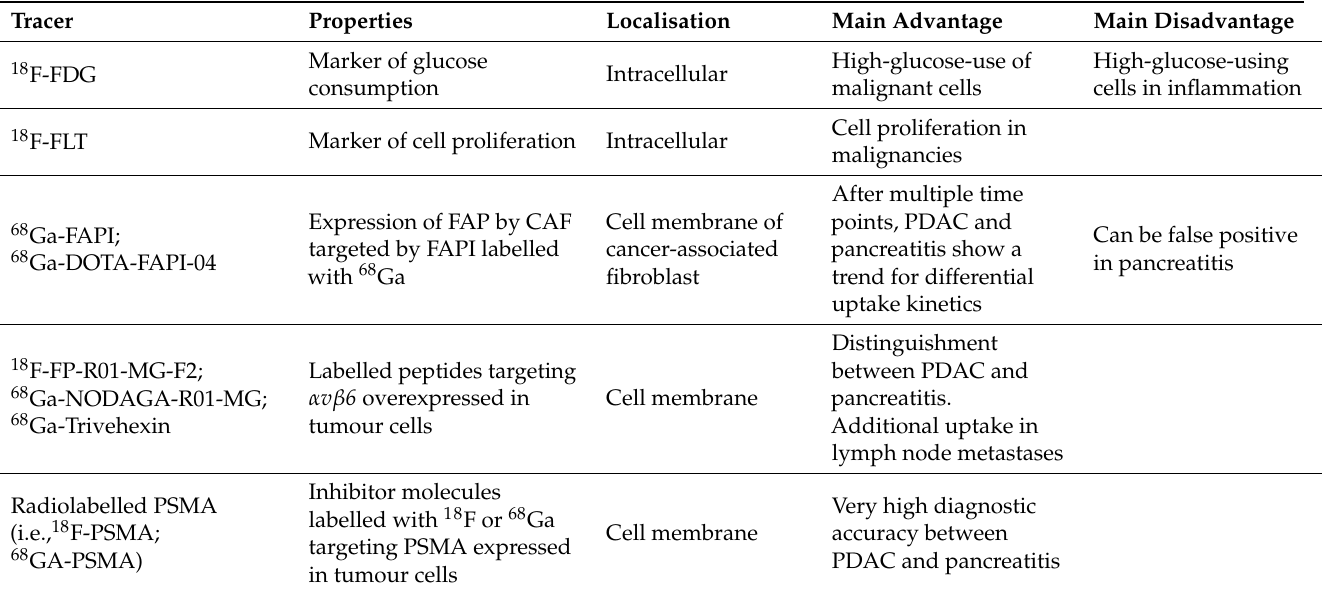
Table 1. Available tracers and their properties for the diagnosis of the primary